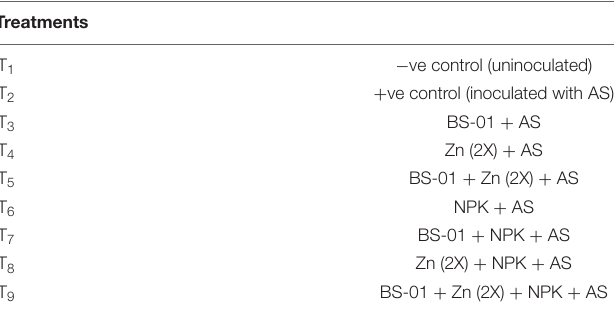
TABLE 1 | Treatments designed for a field experiment. Treatments